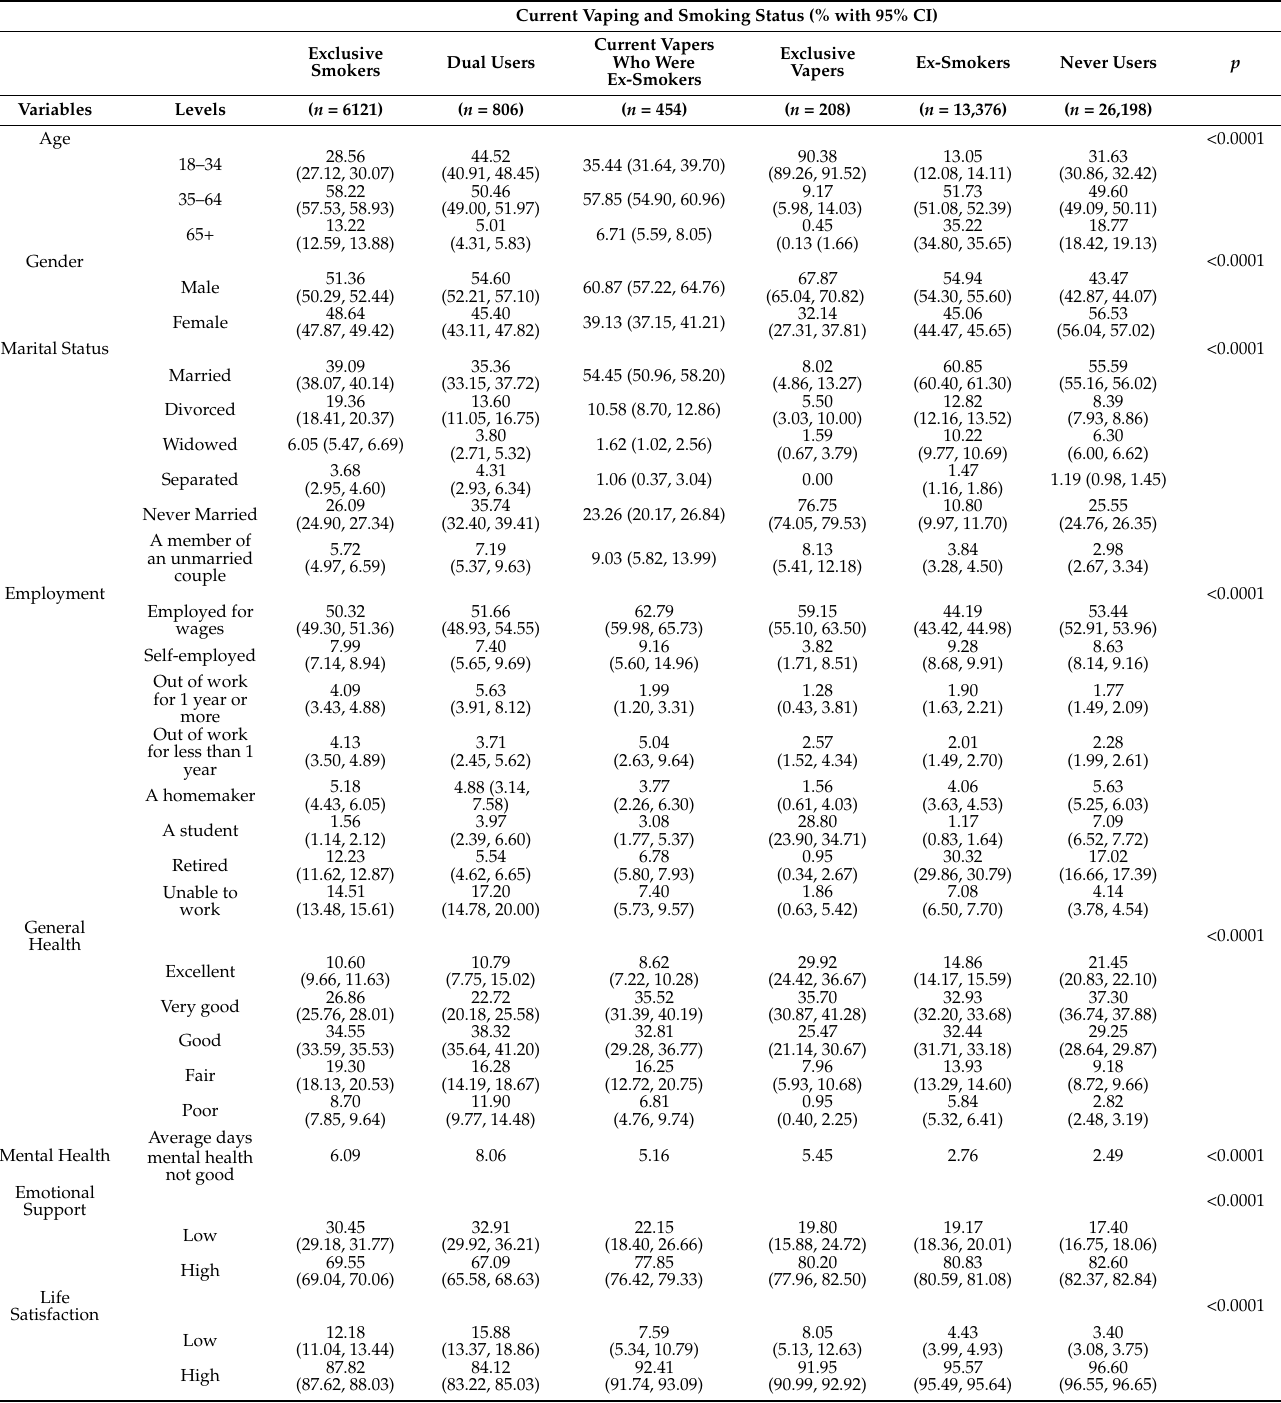
Table 1. The distribution of co-variates within smoking/vaping